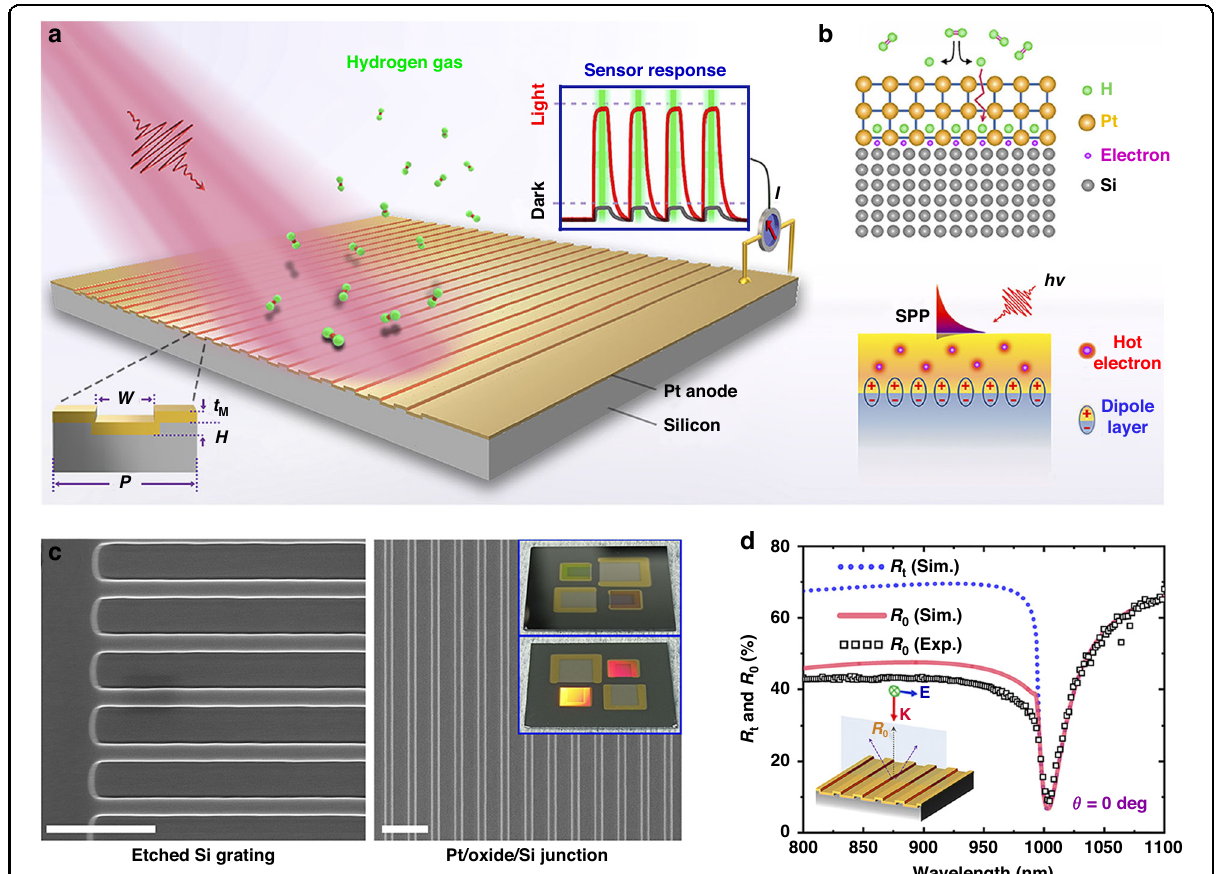
Fig. 1 The plasmonic – catalytic MIS junction used to unravel the interplay between hydrogen molecular and hot electrons. a The surface- relief grating structure on silicon is coated with a conforming thin Pt layer to form the plasmonic absorber. The grating geometry of the absorber is de fi ned by the period ( P ), width ( W ), grating depth ( H ), and the thickness of Pt ( t M ). b The adsorption and dissociation kinetics of the hydrogen molecular on the catalytic metal surface (top); Hot electron generation from plasmon decay and the electrical dipole layer formation due to hydrogen adsorption at metal – insulator interface. c SEM images of the grating structures before (left) and after metal deposition. The insert shows photographs of the grating sample from two different angles. d The experimental and numerically fi tted zero-order re fl ection curves ( R 0 ) at normal incidence. The geometry parameters are summarized as: P = 1000 nm, W = 620 nm, H = 70 nm and t M = 56 nm. These values are in good consistence with our target parameters of fabrication process or the measurements from the SEM images. The total re fl ectance ( R t ) based on the above fi tting parameters are also presented in the